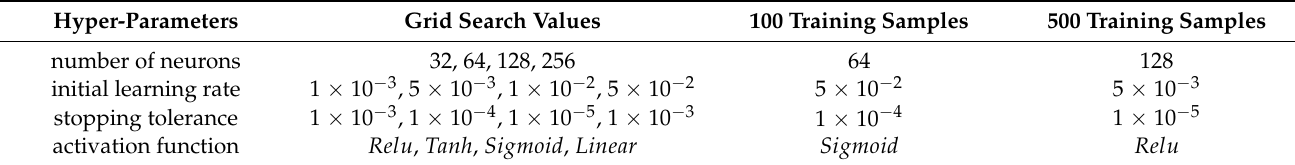
Table 4. The optimal grid values of hyper-parameters when using 100 training samples to train the ML models.